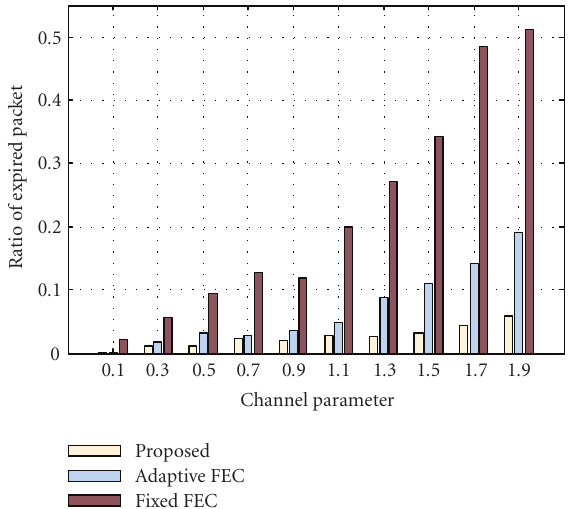
Figure 10: Video quality comparison for transmission using the rateless coding scheme and the EDR FEC-scheme.